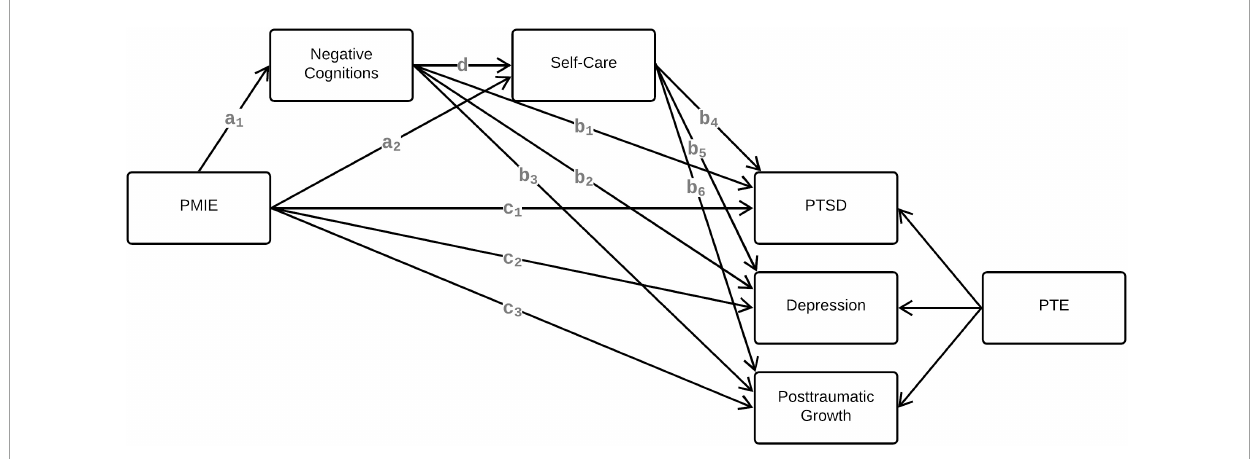
FIGURE1 Hypothesized model for the effect of PMIE on PTSD symptoms, depression symptoms, and posttraumatic growth, after accounting for PTE. PMIE, potentially morally injurious events; PTSD, posttraumatic stress disorder; PTE, potentially traumatic events.